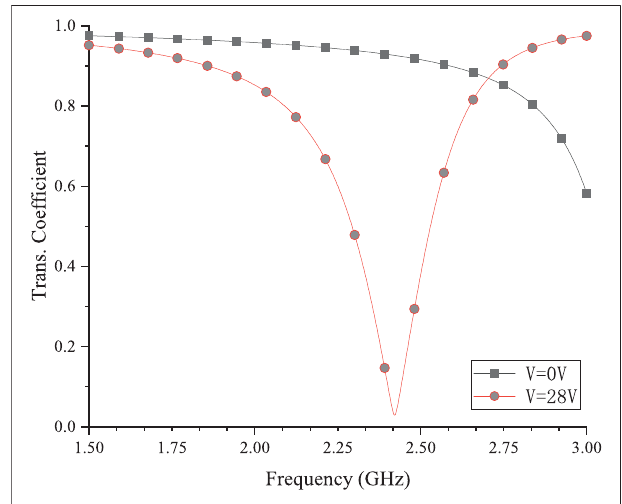
FIGURE5| Thetransmissioncoef fi cientofarecon fi gurablemetasurface at different